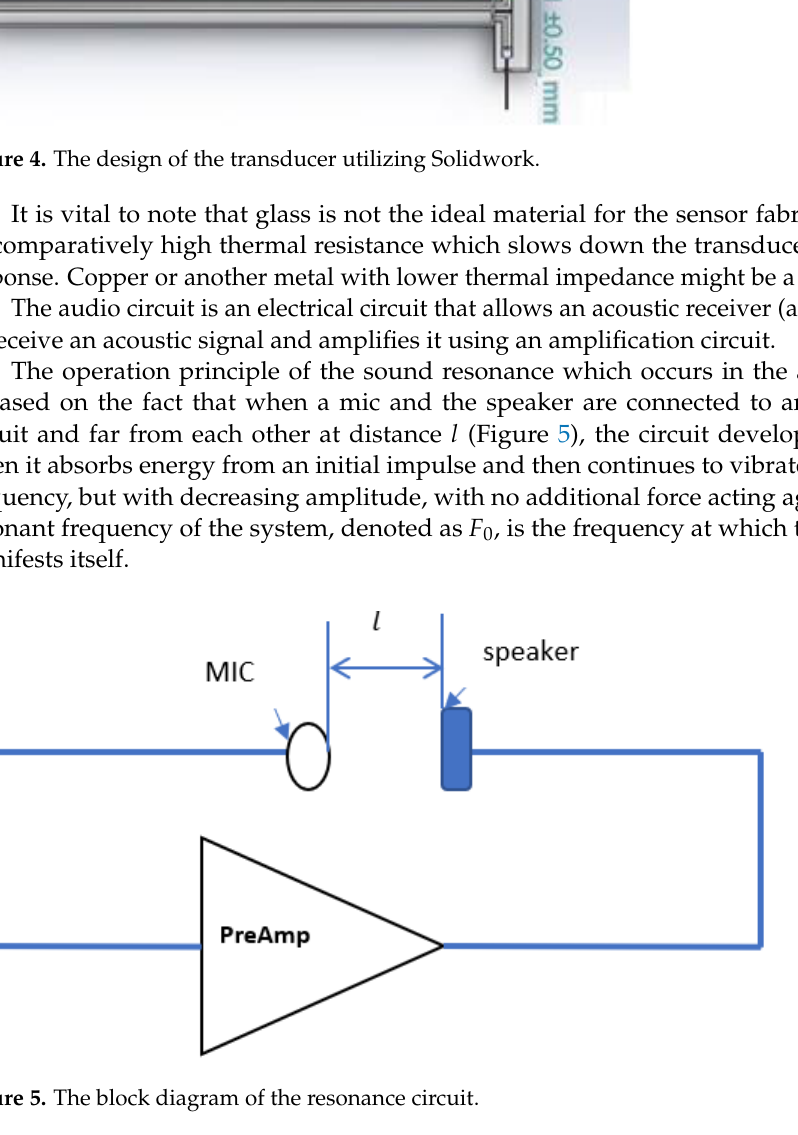
Figure 5. The block diagram of the resonance circuit.